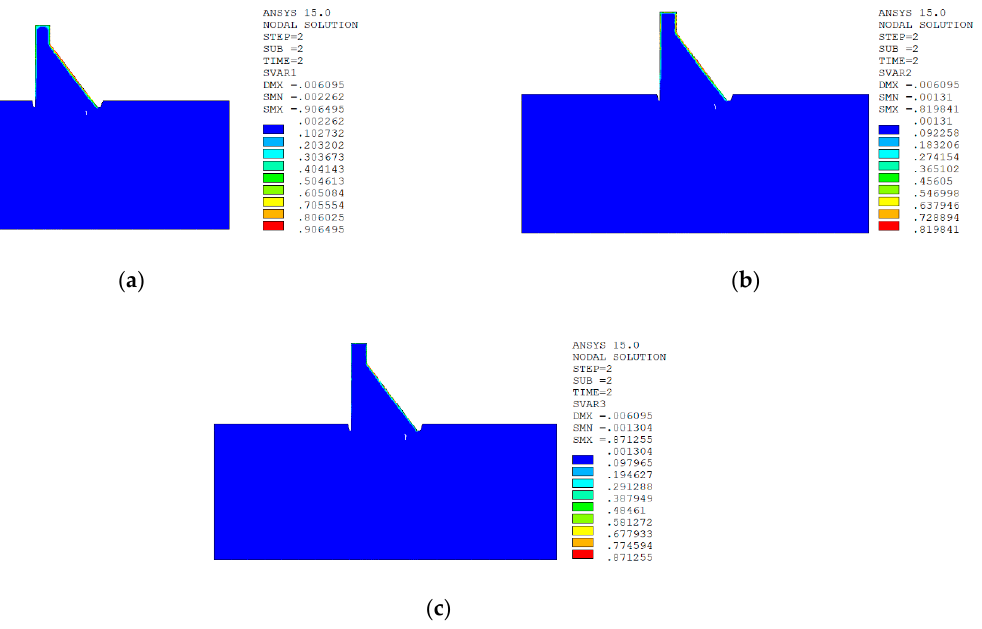
Figure 14. The temperature damage distribution in the three principal strain directions on the section z = 21 m is calculated by the macro-meso model under the temperature drop condition, ( a ) The temperature damage distribution in the first principal strain direction, ( b ) The temperature damage distribution in the second principal strain direction, ( c ) The temperature damage distribution in the third principal strain